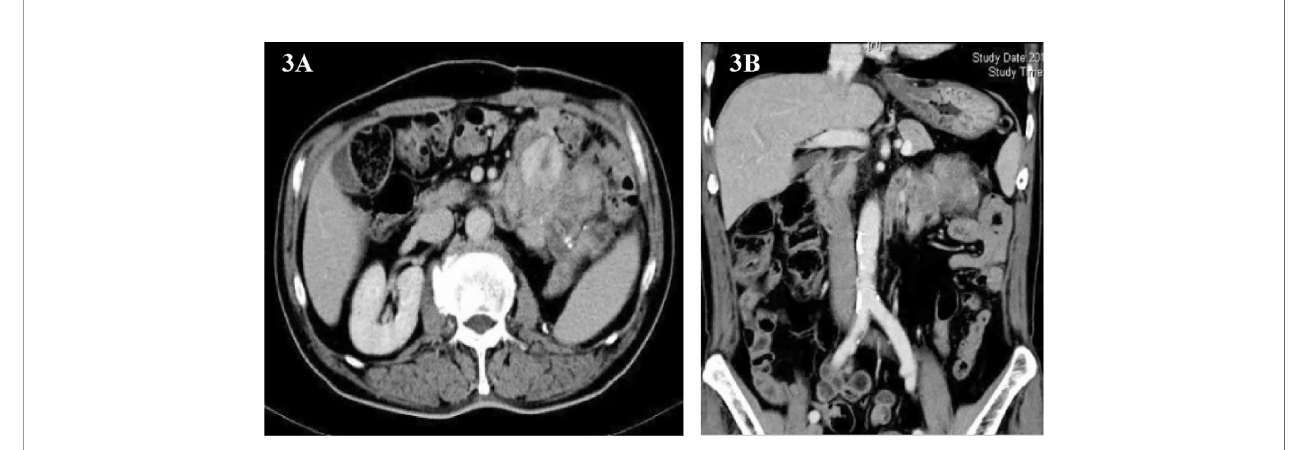
FIGURE 3 | (A, B) Abdominal image before the third